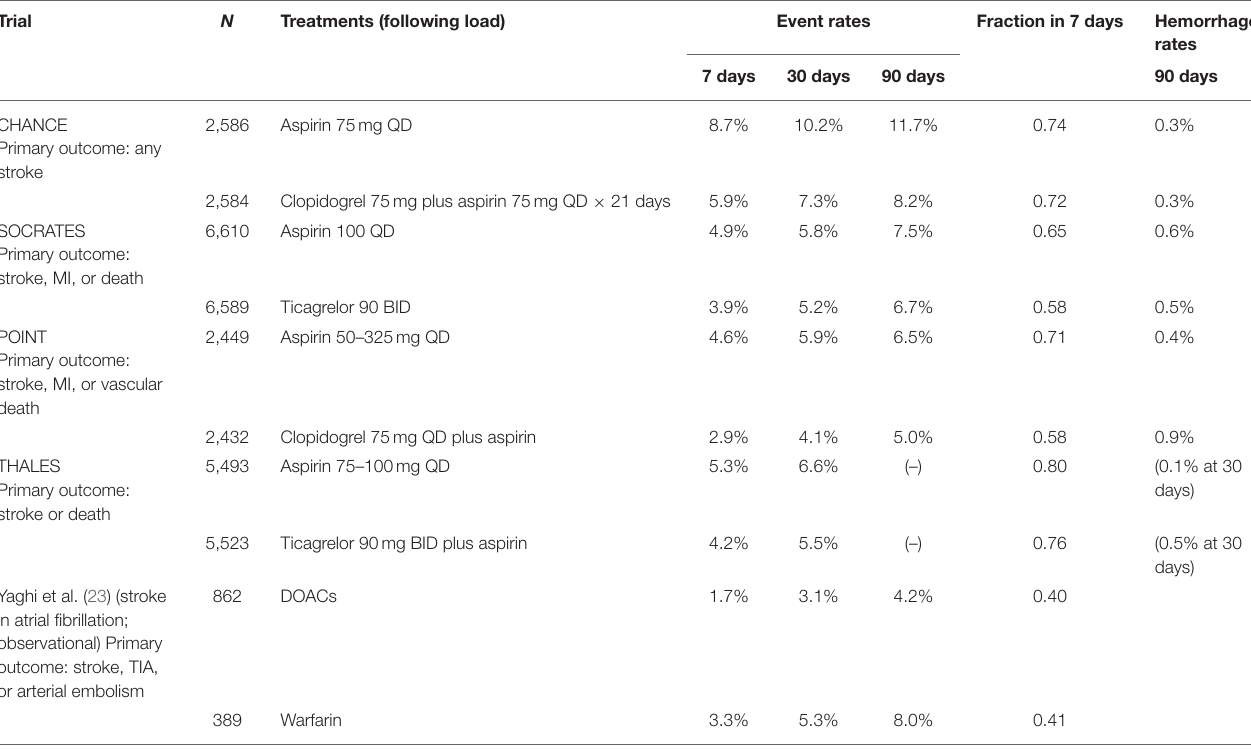
TABLE 1 | Evidence for front-loading of stroke recurrence in selected stroke treatment trials, based on intention-to-treat data for the primary trial outcome event definition (MI: myocardial infarction). Trial N Treatments (following load) Event rates Fraction in 7 days Hemorrhage